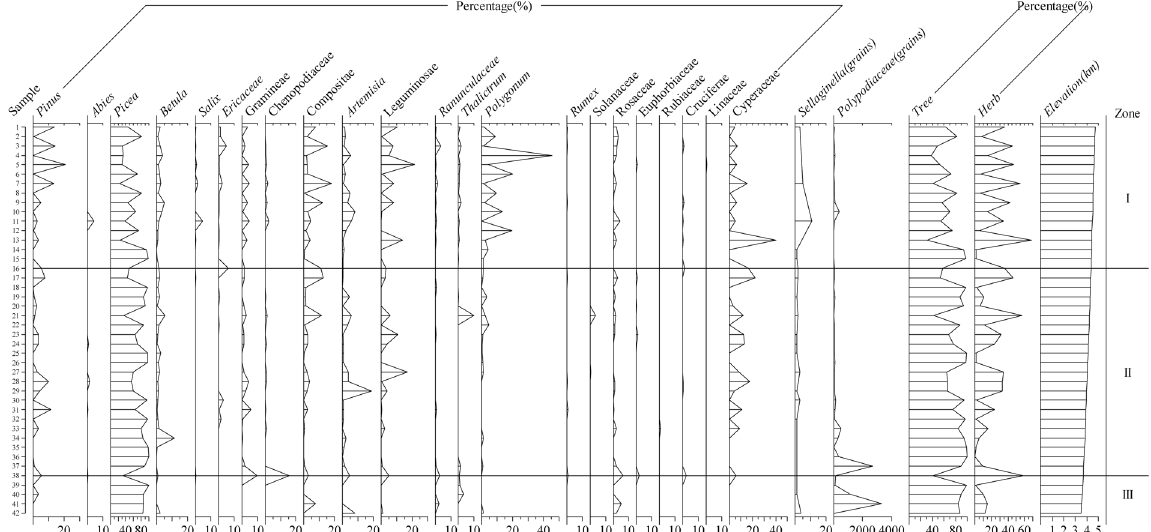
Figure 2. Surface pollen percentages and pollen zones of alpine area from Dingqing county in Tibet, China.